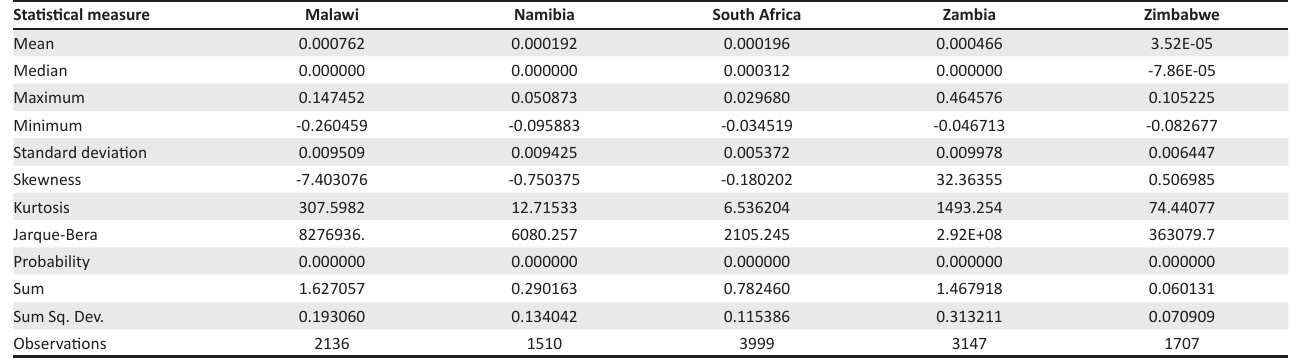
TABLE 2: Descriptive statistics. Statistical